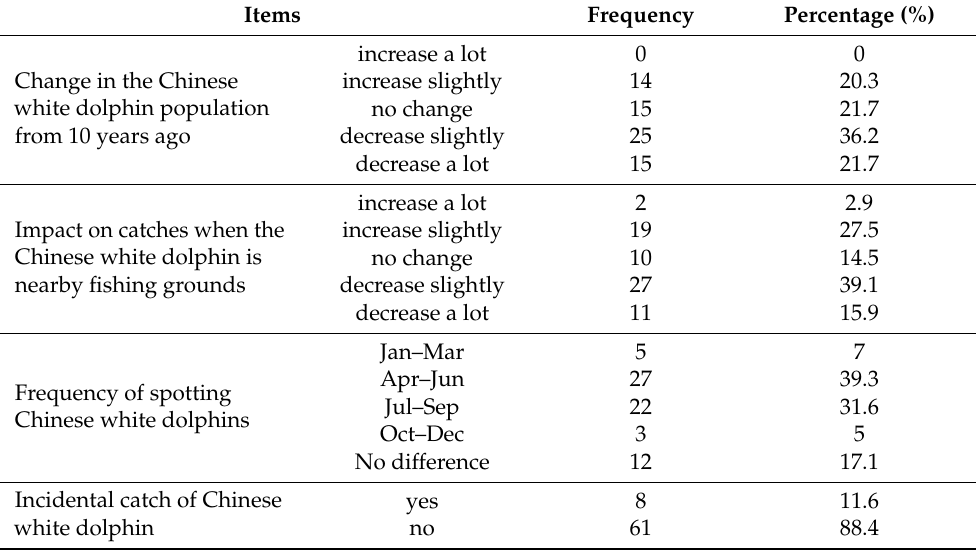
Table 2. Fishers’ experience of the Chinese white dolphin ( n =